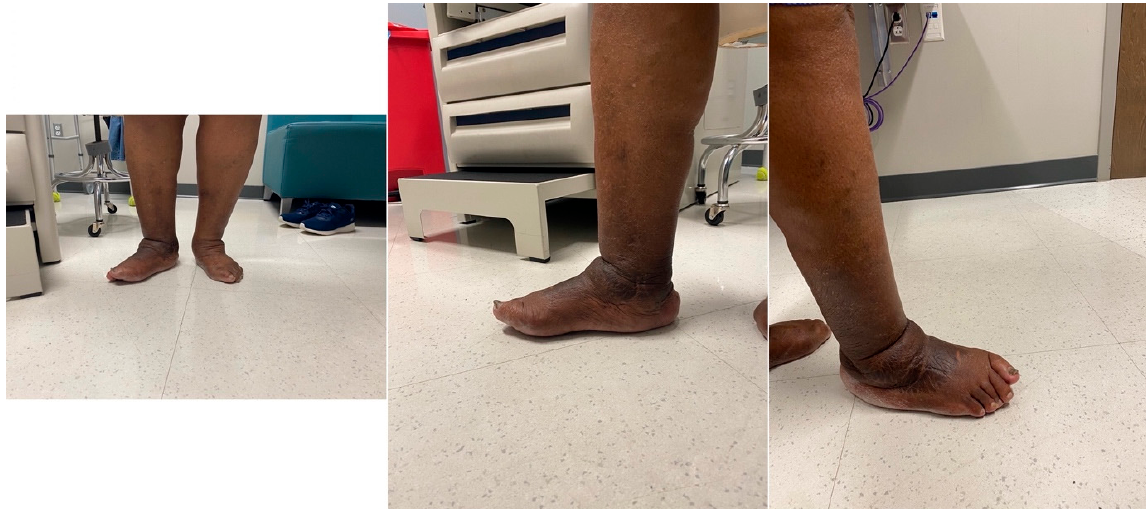
Figure 9. The final one-year post-operative clinical images.